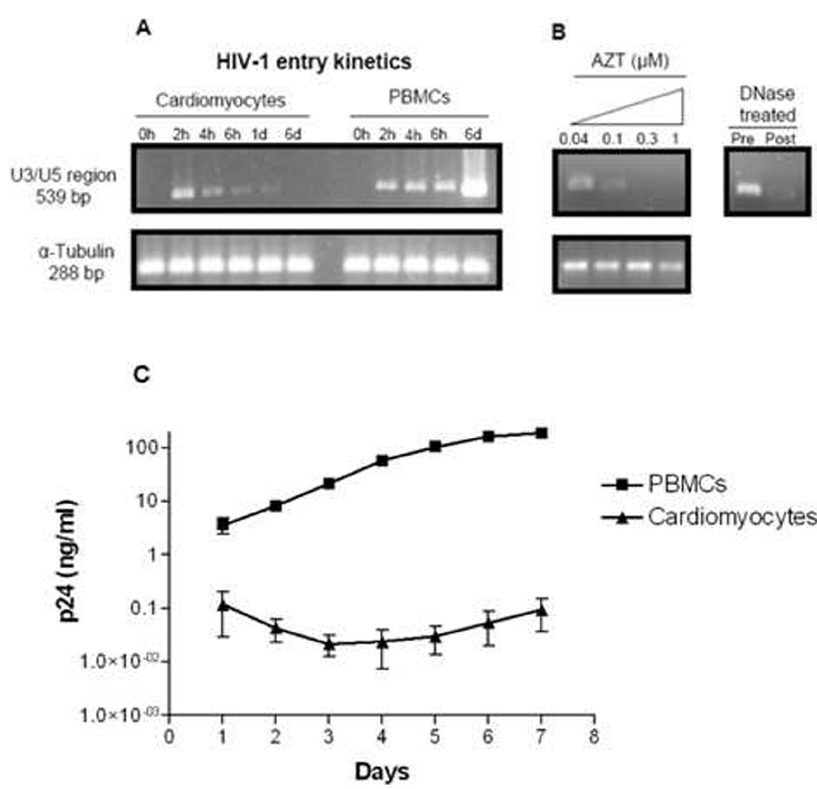
Figure 2. Kinetics of HIV-1 infection of CM and PBMC. (A) Agarose-gel electrophoresis of the PCR-amplified U3/U5 region of a dual tropic (R5X4) HIV-1 subtype C isolate called HIV-1 CM9 infected culture lysates at different times after infection. The 539 bp fragment indicates the presence of proviral DNA. A 288 bp region of the gene coding for a -tubulin is a control ensuring equal loading of the wells. (B) Proviral DNA in CM exposed to serial dilutions of AZT. (Insert) Agarose-gel electrophoresis of cell-free HIV-1 CM9 culture digested with DNaseI for 1 h prior to infection. (C) Detection of replication of HIV-1 CM9 in CM and PBMC using p24 ELISA.